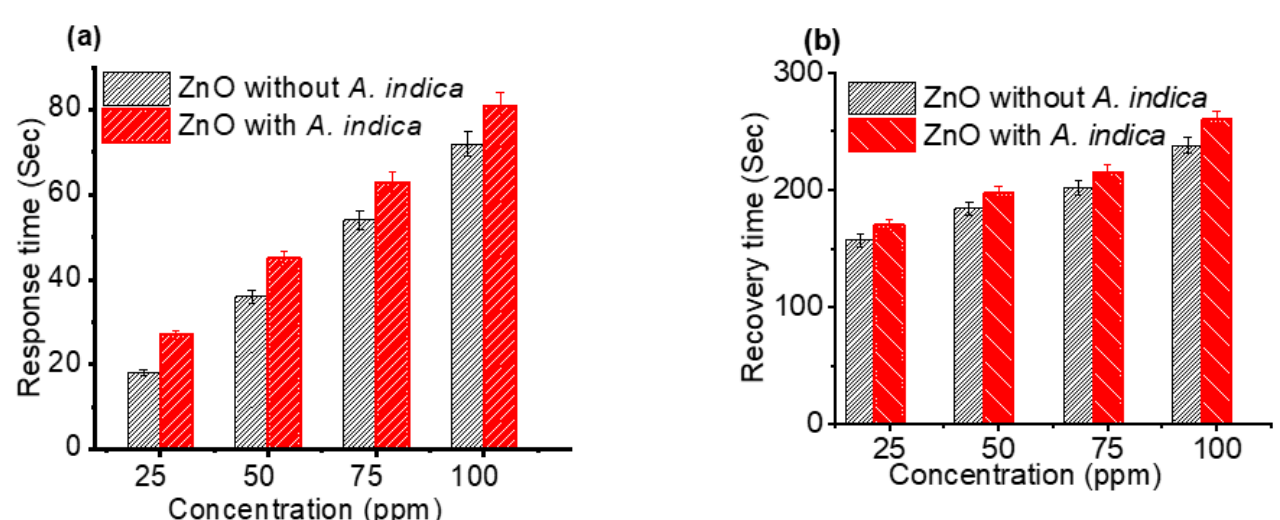
Figure 7. ( a ) Response time of ZnO thin films as a function of concentration and ( b ) recovery time of ZnO thin films as a function of concentration.